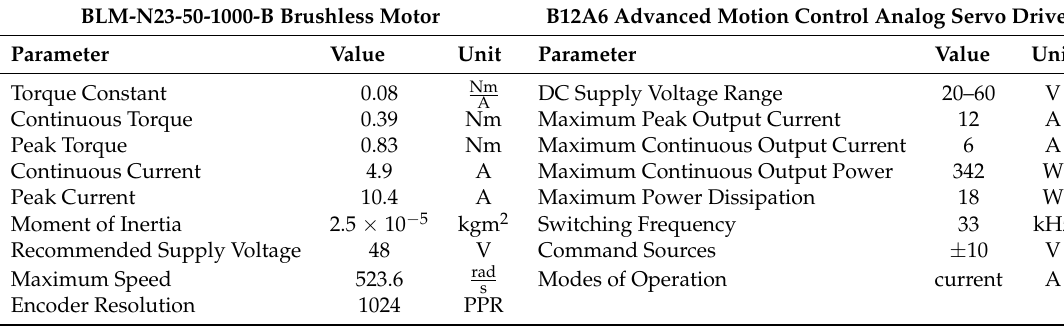
Table 2. Parameters of test bench.